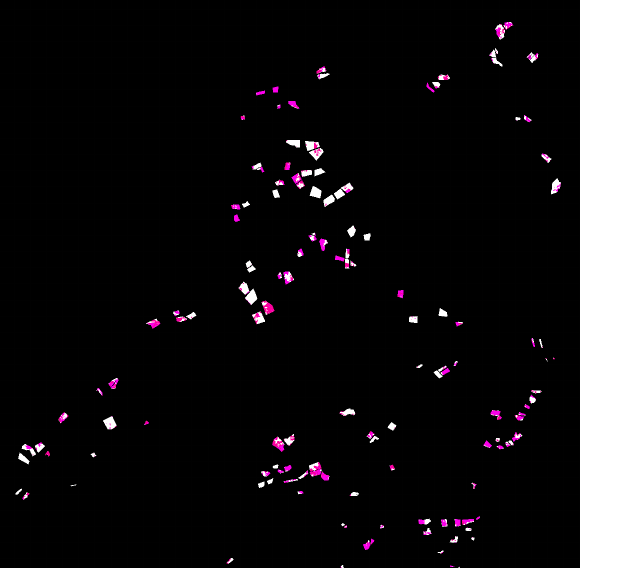
Figure 3. STL-map of the r 1 pattern, for ground truth areas covered by pastures, in the region of la Plaine des Cafres .